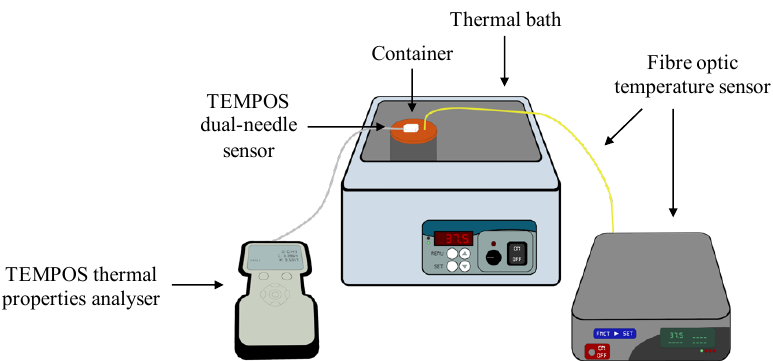
Figure 1. Experimental setup: TEMPOS thermal properties analyser, metallic container, thermal bath and fibre optic temperature sensor [33].